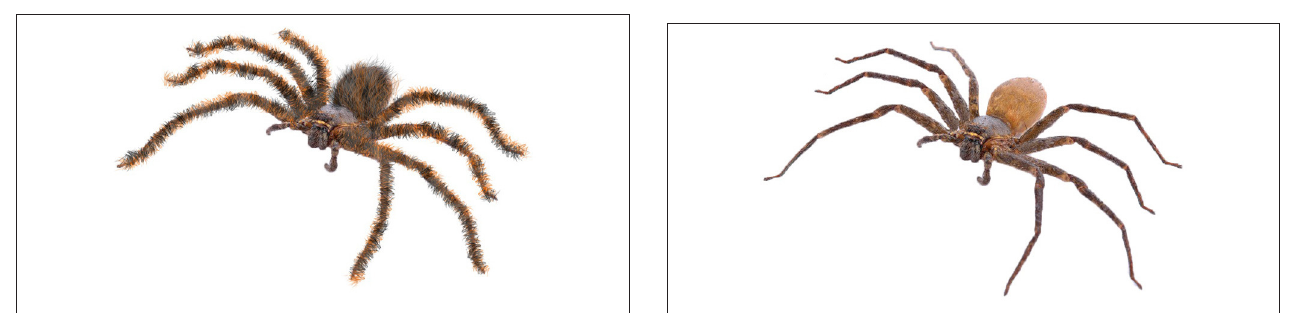
FIGURE 2 | Experimentally manipulated body hair of spider.